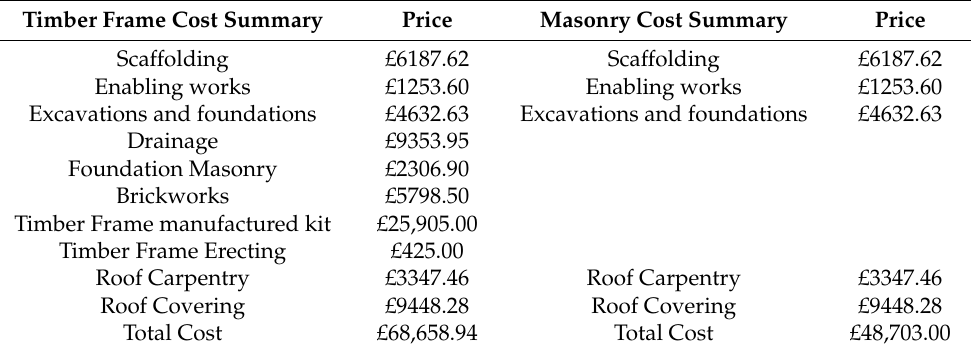
Table 2. Breakdown of shell construction by timber frame vs.